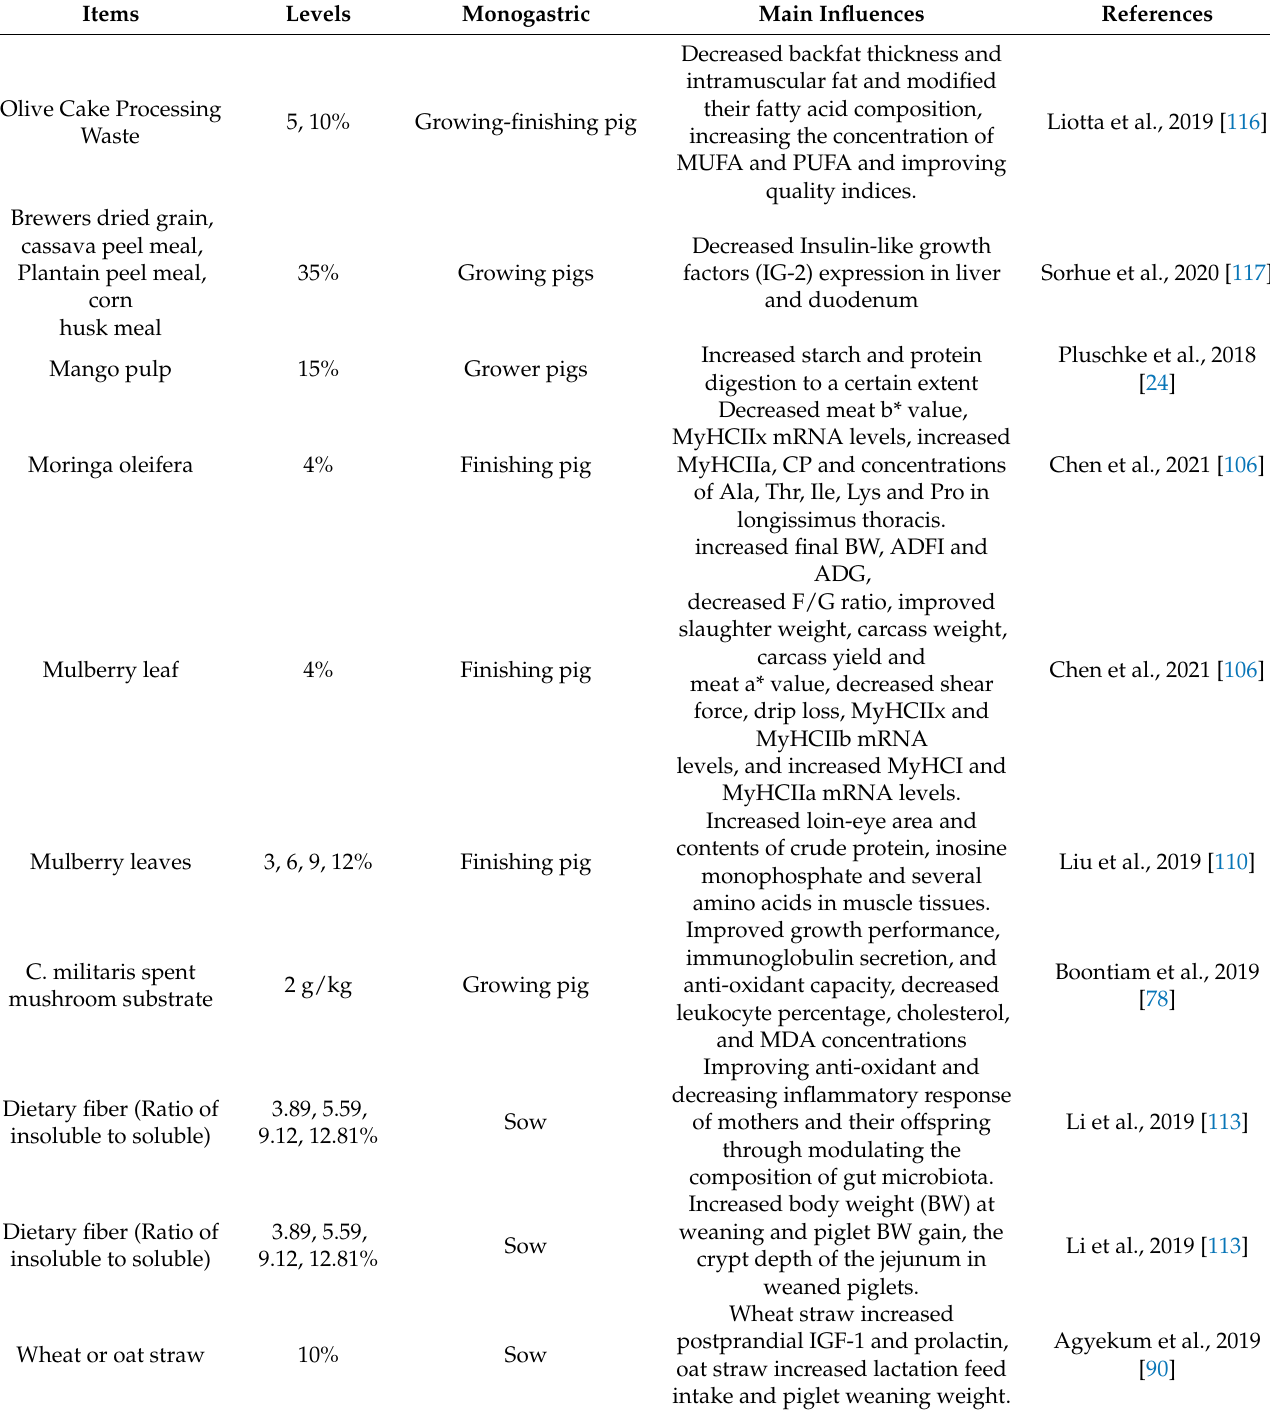
Table 3. Applications of agro-industry by-products as feeds in